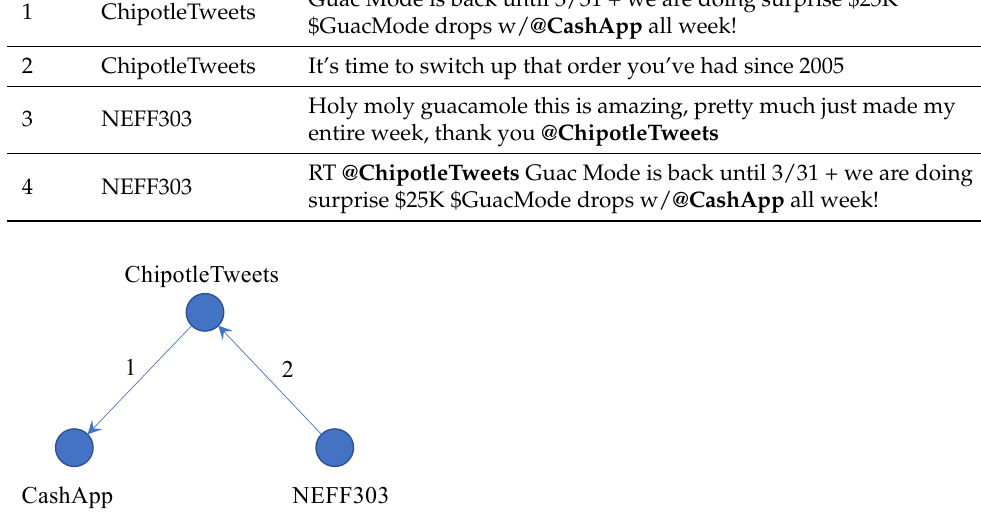
Figure 2. The extracted interaction graph from the data in Table 1. The numbers on the edges denote the interaction frequency between a pair of users.